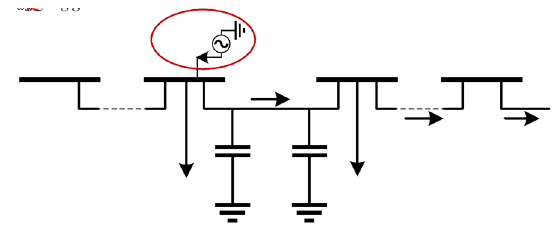
Fig. 2: Distribution Network with DG Installation at Bus